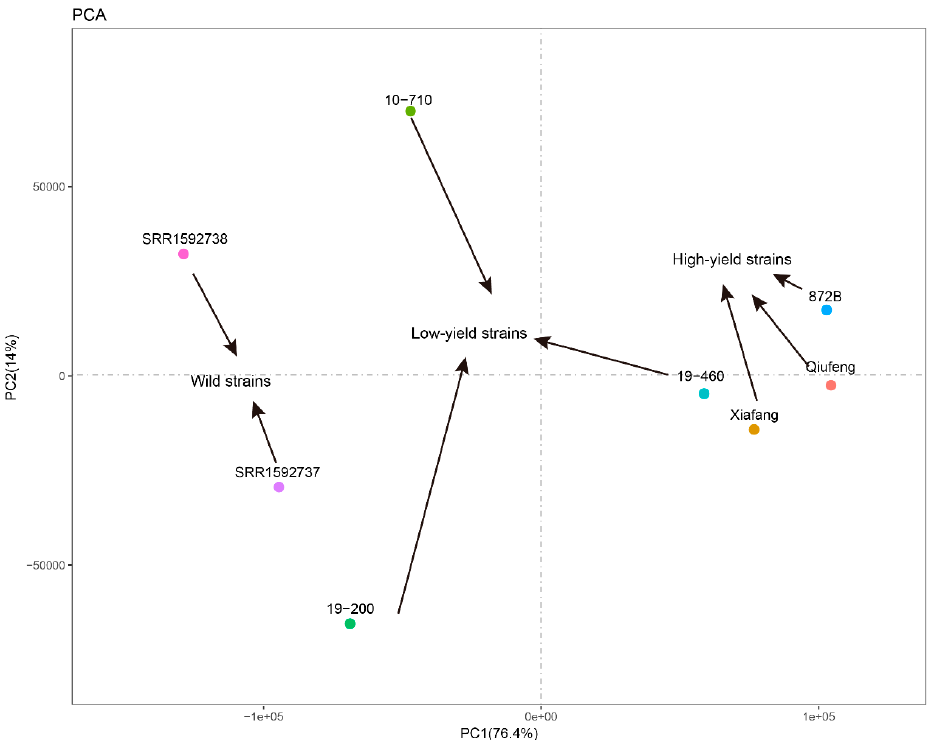
Figure 7. Principal component analysis (PCA). The numbers 1, 2, and 6 represent high-yield strains; 3, 4, and 5 indicate low-yield strains; and w1 and w2 are wild silkworms. The wild silkworm transcriptome data, w1 and w2, were derived from a comparative analysis of the silk gland transcriptomes between the domestic and wild silkworms [Fang et al. BMC Genomics